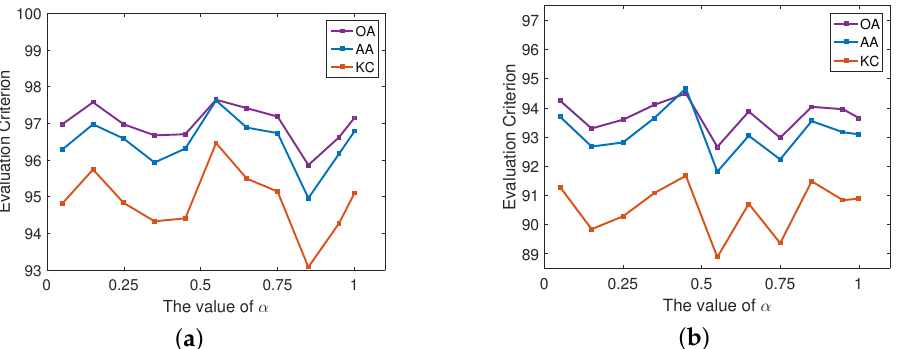
Figure 12. Effect of α on classification performance of the proposed PSCAN. ( a ) Results when RS-2 is the target. ( b ) Results when GF-3 is the